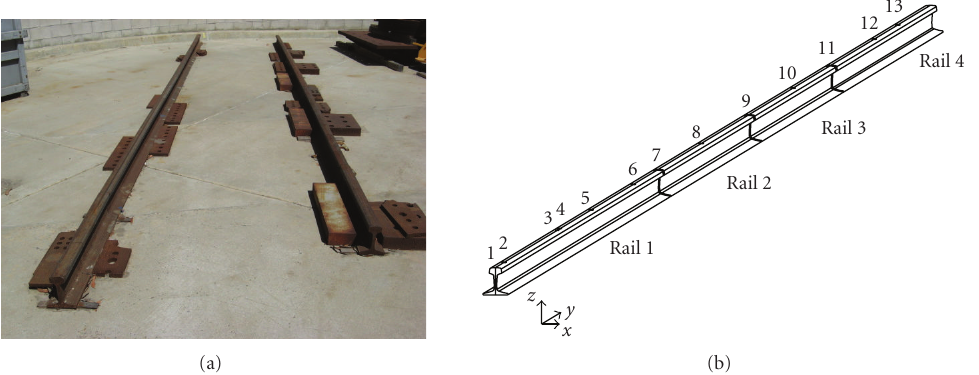
Figure 2: (a) Photo of the rail track mockup at UCSD; (b) layout of the tested mockup. The numbers on top of the rail layout represent the location number listed on the second column of Table